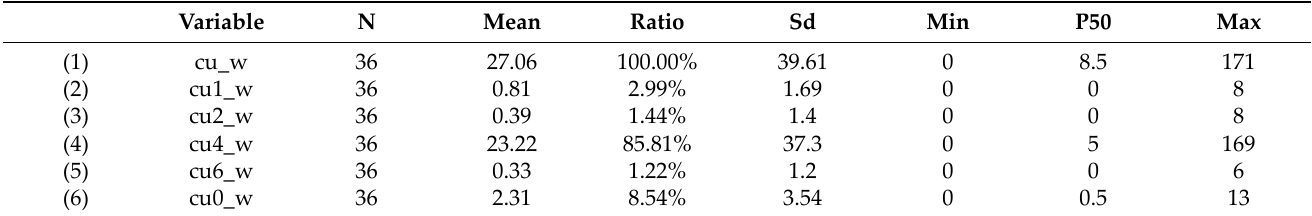
Table 4. Results of the level‑2 customer subdimension analysis on social